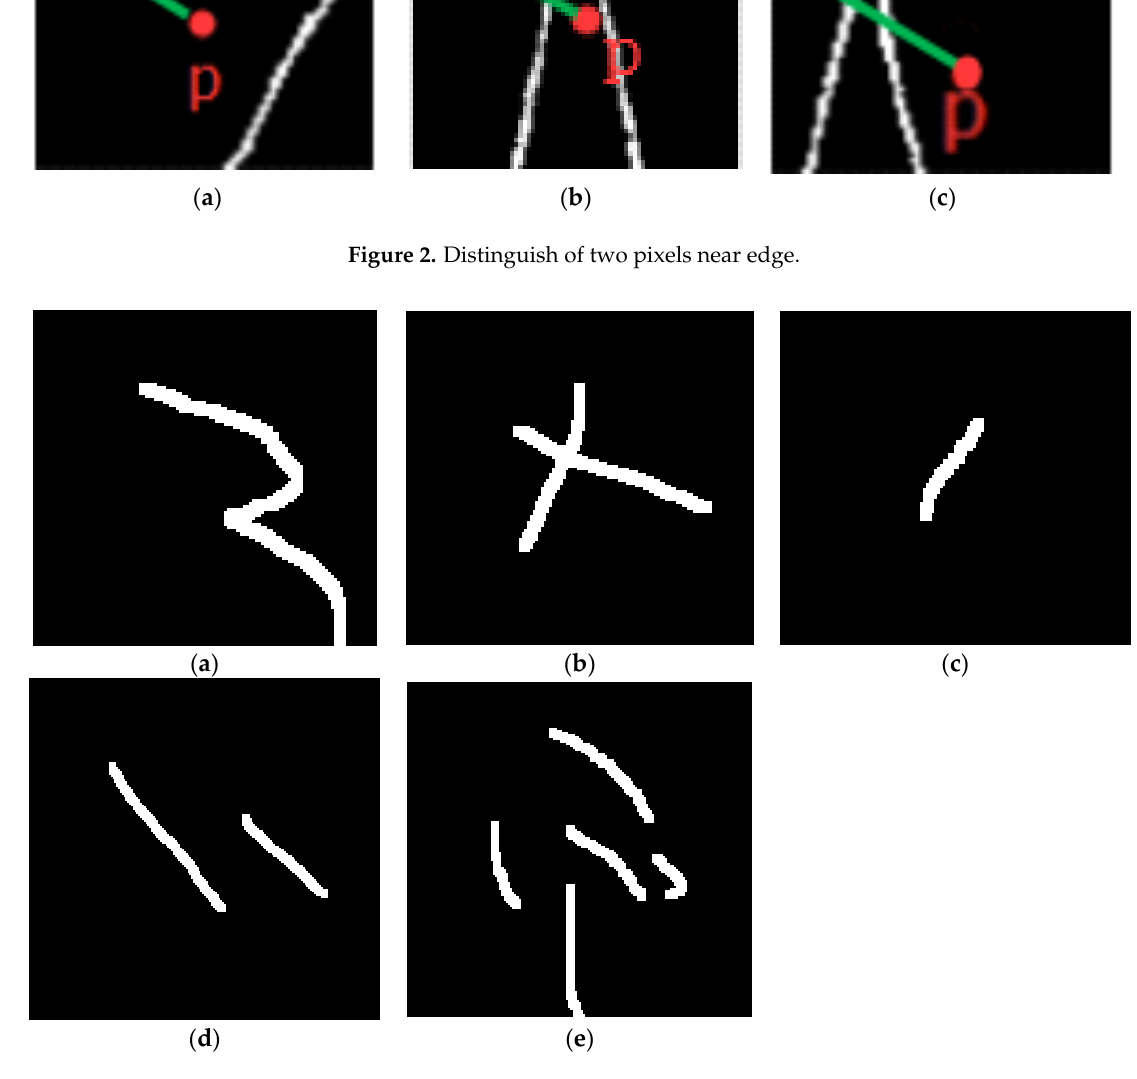
Figure 2. Distinguish of two pixels near edge.